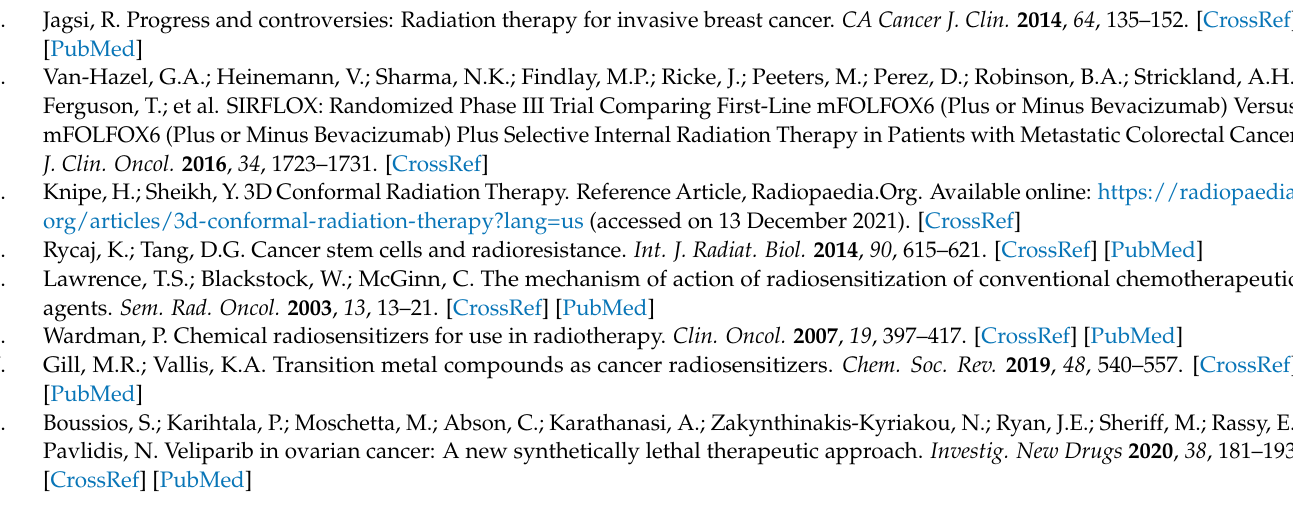
concentration in two HNSCC cell lines and two normal cell lines as determined via the MTT assays. Table S1: Relative boron amount in A2780 cells treated with carrier, prodrugs 1 or 2c, Table S2: Effects of the prodrugs on the viability of A2780 cell lines (IC 50 values) after different incubation times, Table S3: Effects of the prodrugs on the viability of BL2 cell line (IC 50 values) after 48 and 96 h incubation, Table S4: Effects of the prodrugs on the viability of AsPC1 cell lines (IC 50 values) after 72 h incubation, Table S5: Effects of the prodrugs on the viability of Jurkat cell lines (IC 50 values) after 48 h incubation, Table S6: EC 50 values (50% survival) in cancer SAS and FaDu cells determined via the MTTassay after 48 h of exposure to the prodrugs, Table S7: EC 50 values (50% survival) in representative normal ARPE-19 and human fibroblasts (HF) cells determined via the MTT assay after 48 h of exposure to the prodrugs, Table S8: EC 20 values (80% survival) in cancer SAS and FaDu cells determined via the MTT assay after 24 h and 48 h of exposure to the prodrugs, Table S9: Effects of the prodrugs on the capacity of SAS and FaDu cells to form